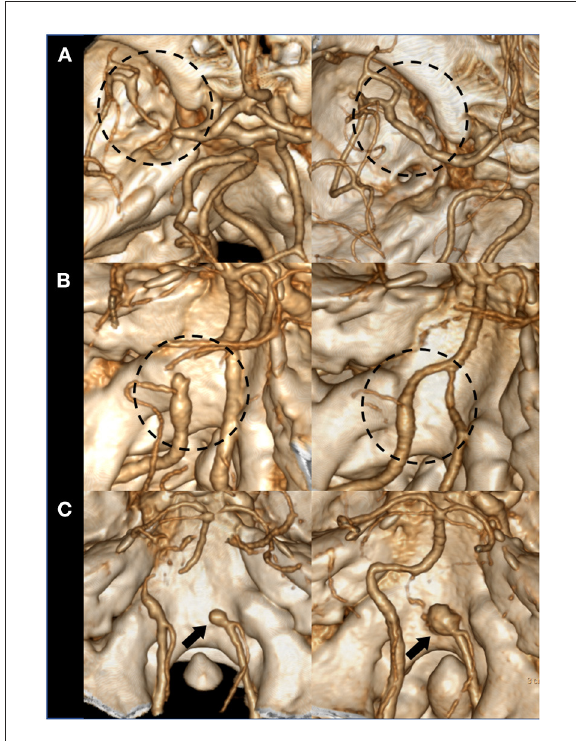
FIGURE2 Examples of spontaneous arterial healing and aneurysmal changes. (A) An originally stenotic dissection segment shows arterial healing with improved stenosis degree. (B) A dissection segment with dilatation pattern (dilatation & stenosis) shows arterial healing with reduced aneurysm size and improved stenosis. (C) An initially dilated dissection segment shows aneurysmal enlargement on serial